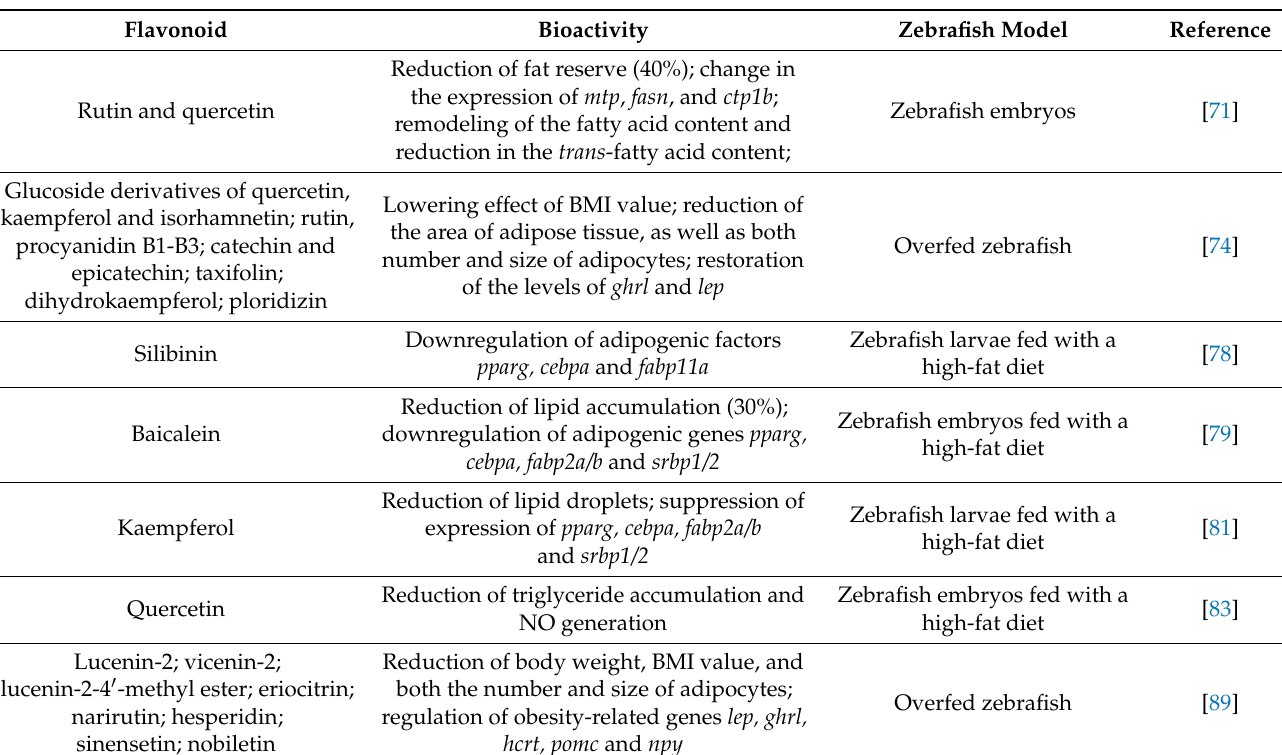
Table 2 summarizes the anti-obesity properties of the flavonoids discussed in this section. Table 2. Anti-obesity effects of flavonoids in